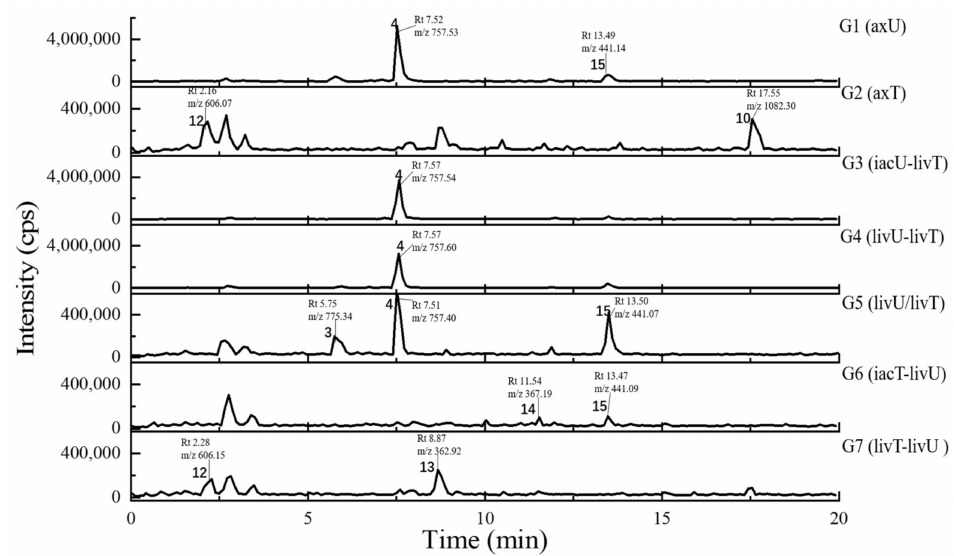
Figure 7. The LC-MS traces (base peak chromatographies, BPC) under negative ion mode of the culture extracts. The samples include axU (G1), axT (G2), iacU-livT (G3), livU-livT (G4), livU/livT (G5), iacT-livU (G6), and livT-livU (G7). The numbers marked on the peaks or in the UV spectra are numbers for the peaks with remarkable yield changes detected by mass spectrometry and are consistent with the peak numbers in Table